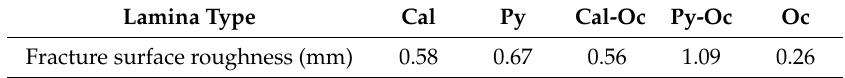
Table 4. Variation in fracture surface roughness parameters of the Longmaxi Shale